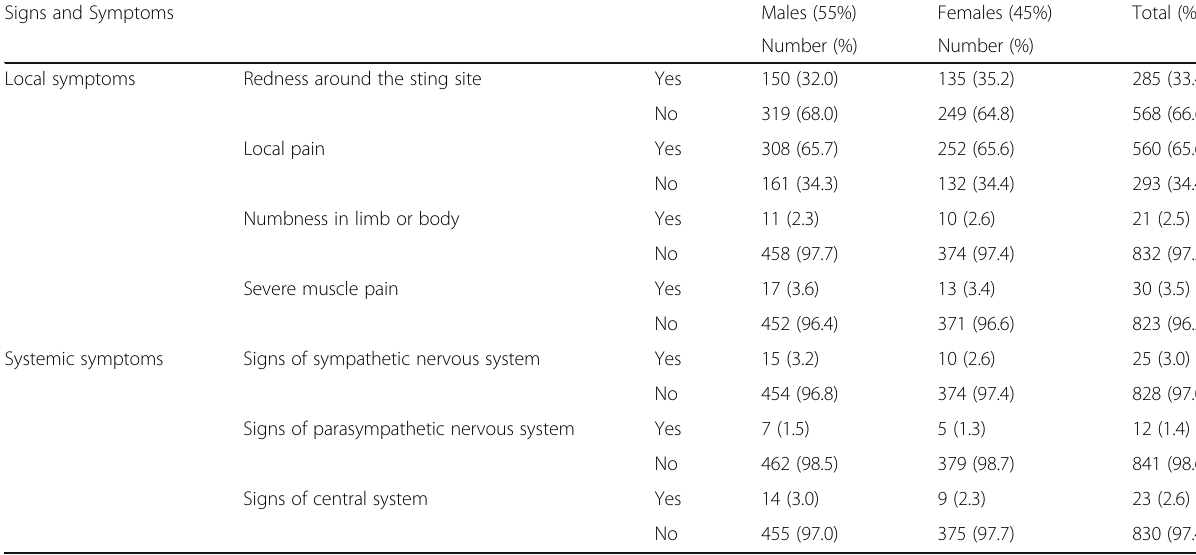
Table 3 Description of clinical signs and symptoms of patients stung by scorpions ( n = 853) Signs and Symptoms